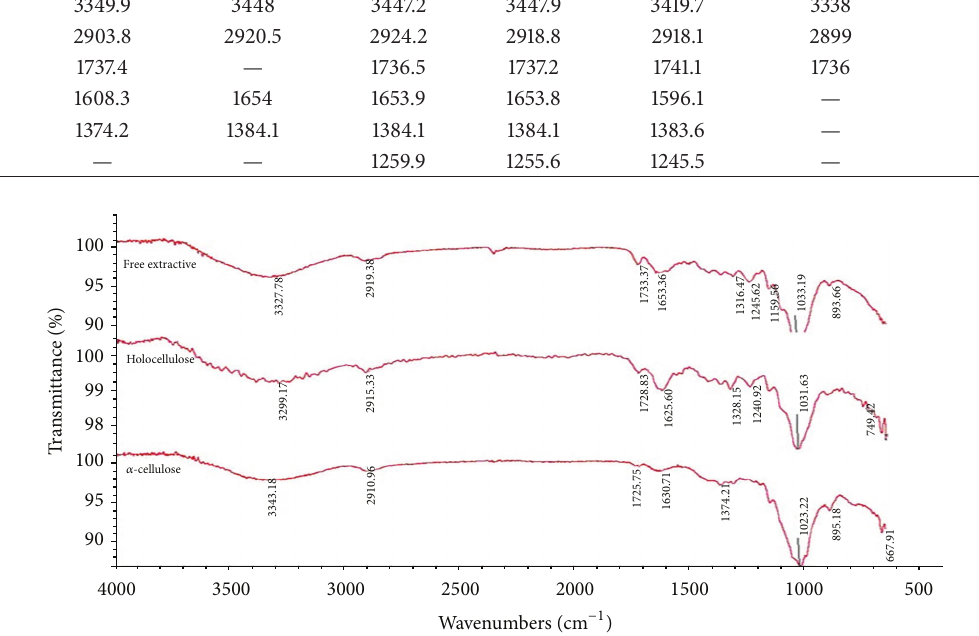
Figure 2: FTIR spectra of pineapple leaf fiber in various forms [54] (With